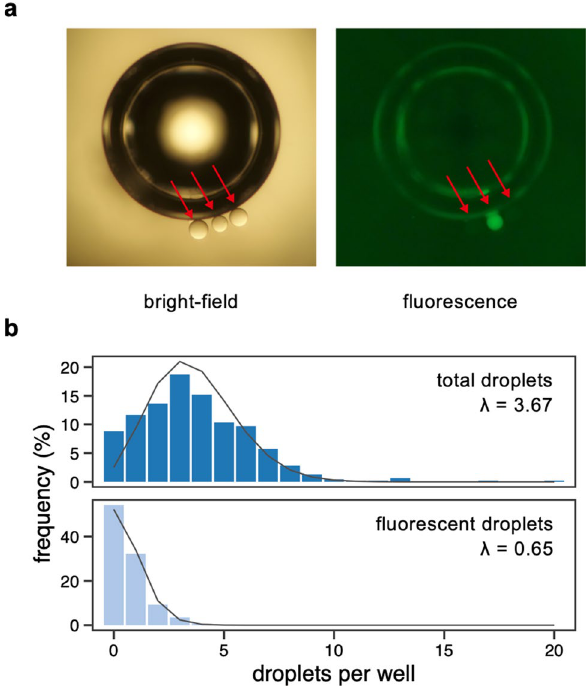
Figure 3. Droplet collection by microdispensing. ( a ) Bright-field (left panel) and fluorescence (right panel) micrographs of a single representative well containing three total droplets (marked by arrows), with a single fluorescent droplet in the middle. Note that the large concentric circles visible in both images are due to an air bubble entrapped in the microwell. The diameter of droplets is approximately 120 µm. ( b ) Frequency of total and fluorescent (that is, FNAP-positive) droplets collected in multiwell microplates by microdispensing, as evaluated by bright-field and fluorescence microscopy. Grey solid lines represent Poisson distributions fitted to the data. Indicated lambda (λ) values are the expected number of droplets per well based on the fitted Poisson